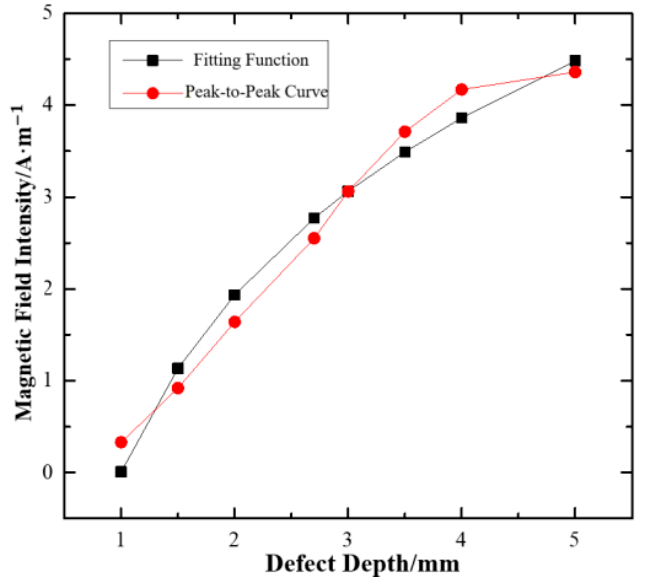
Figure 14. Peak-to-peak values’ function and fi tt ing curve in Bz direction.